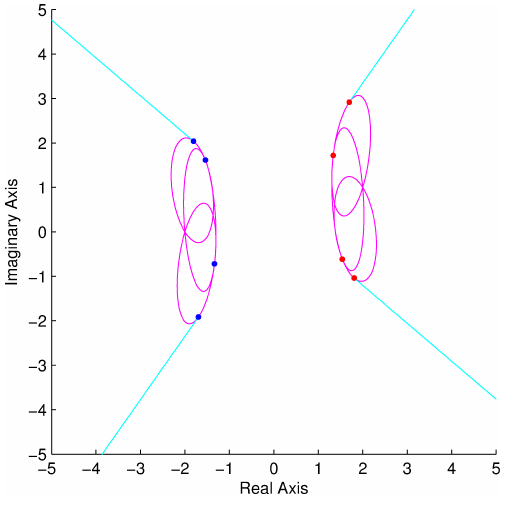
Fig. 3. W J .T/ for Example